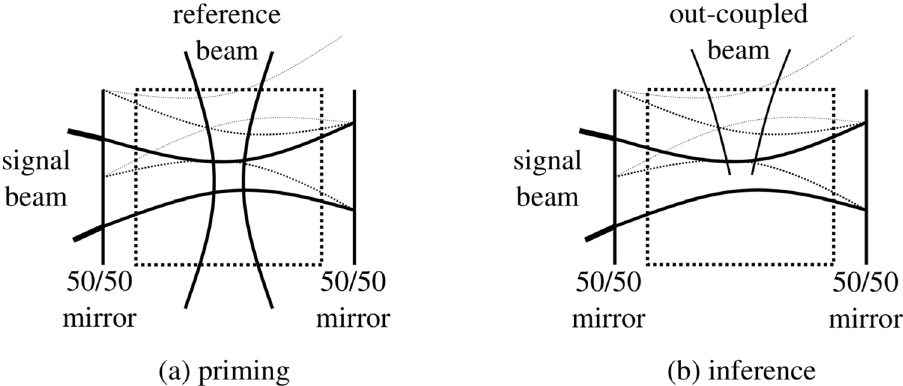
Figure 2. (a) During priming , a random input signal is sent through the cavity containing a photorefractive crystal while a reference beam is active. The signal beam enters the cavity through a 50/50 mirror and will reflect at the other side of the cavity on another 50/50 mirror. Due to interference with the reference beam (and with reflections of the signal beam itself), induced gratings start to form inside the photorefractive crystal for common patterns in the signal beam. These gratings will in turn influence the propagation of the light through the crystal. When the induced gratings become strong enough, beam coupling occurs. (b) During inference, the signal beam will still interact with the gratings created during the priming step These interactions with the photorefractive crystal might give rise to beams that are coupled out of the photorefractive crystal and slower propagation times through the crystal. Overall, such a primed crystal will perform better as a reservoir on the benchmark tasks considered here than the non-primed crystal. This figure was created with